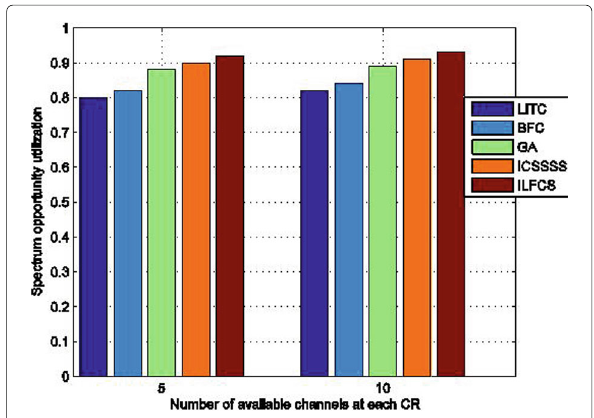
Fig.22 Spectrum opportunity utilization for LITC, BFC, GA, ICSSSS, and ILFCS in case of high PU activity. The results of different simulation experiments to measure spectrum opportunity utilization for LITC, BFC, GA, ICSSSS, and ILFCS in case of high PU activity are